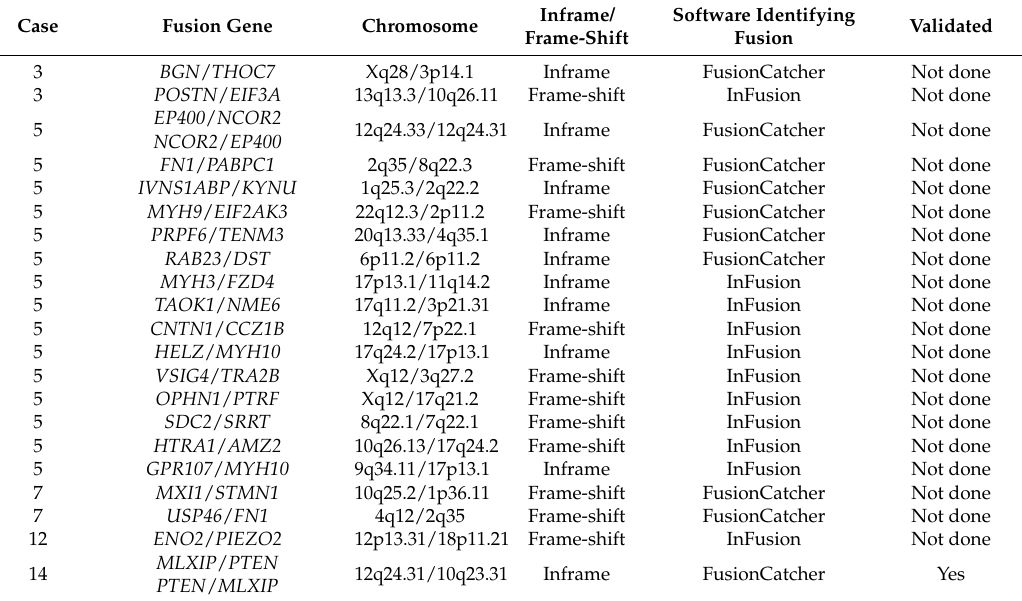
Table 2. Fusion genes detected in twelve cases of primary anaplastic thyroid